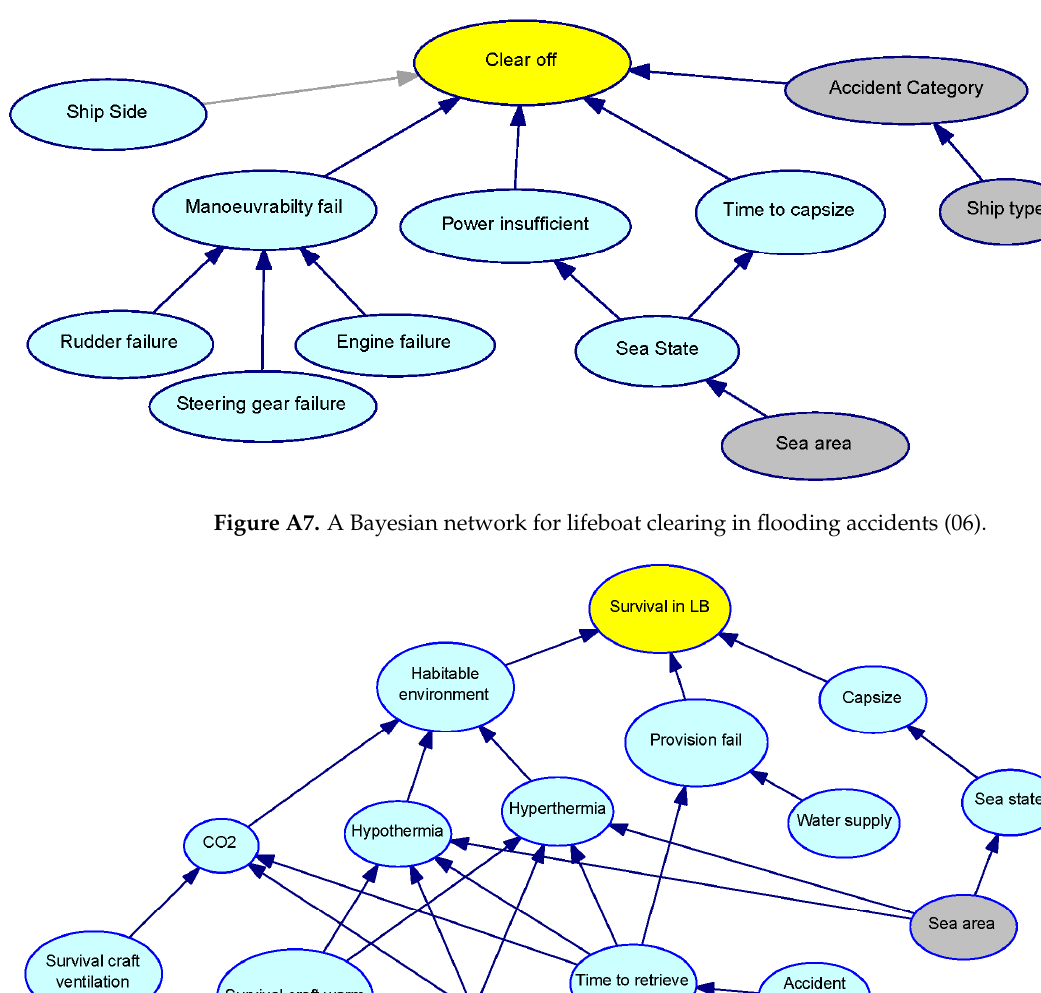
Figure A9. A Bayesian network for survival at sea in both flooding and fire/explosion accidents (08).